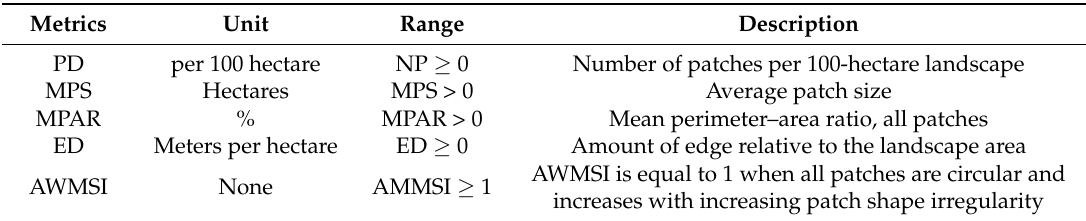
Table 3. Selected landscape